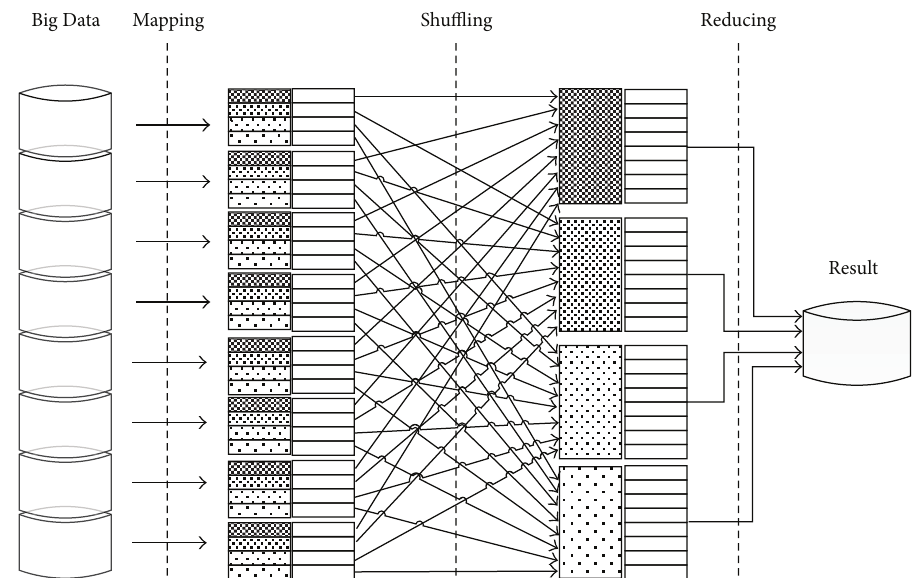
Figure 5: MapReduce